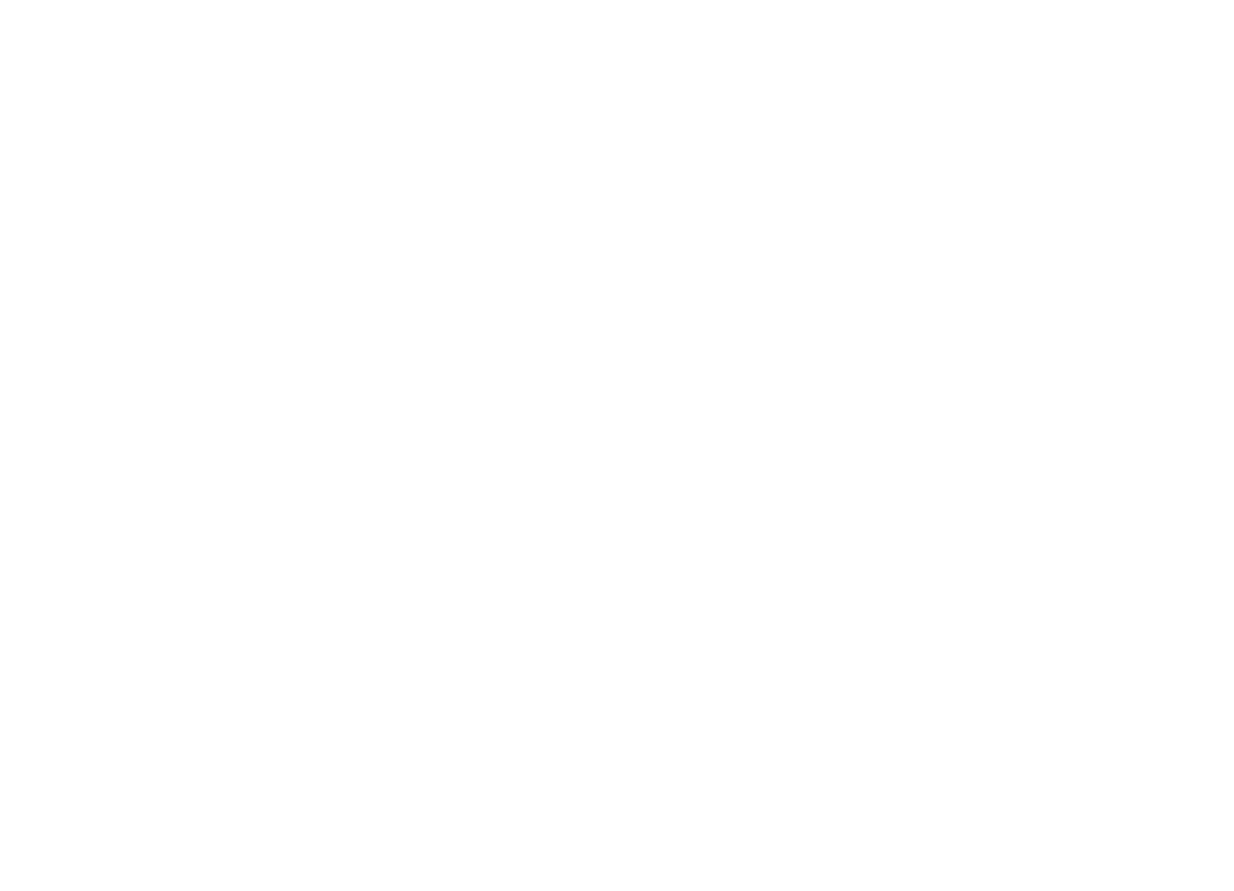
Frontiers in Earth Science |